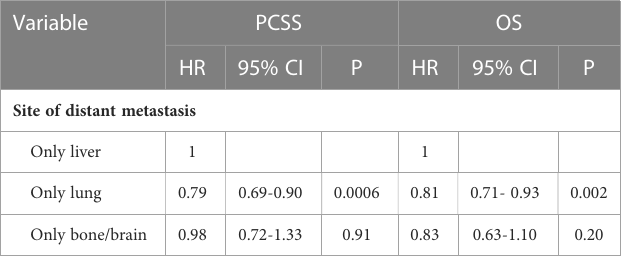
TABLE 4 Univariate Cox-regression analysis of the site of DM for cancer- speci fi c survival and overall survival. Variable